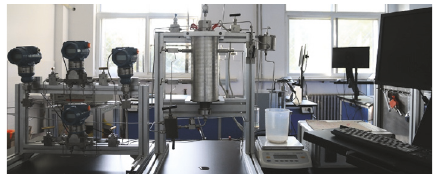
Figure 5: Multistep coreflood platform in the